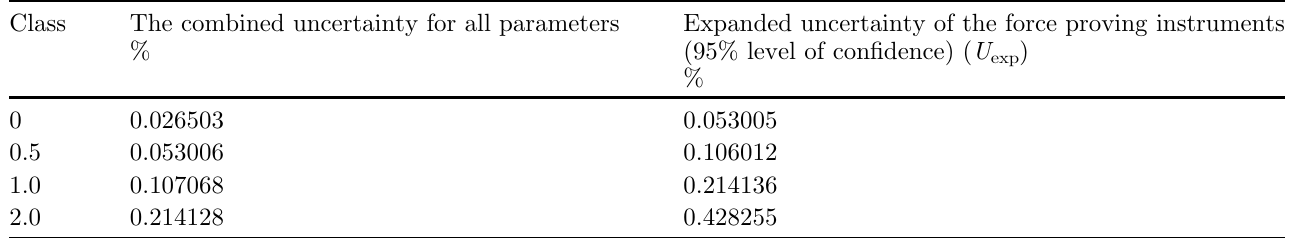
Table 3. New expanded